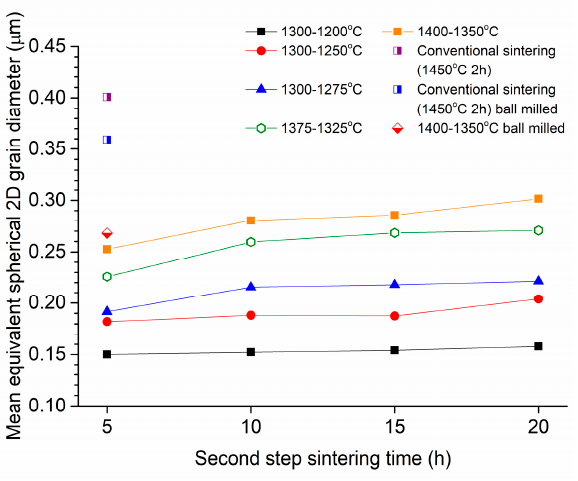
Figure 7. Mean grain size of samples after two-step sintering vs. second step sintering time.